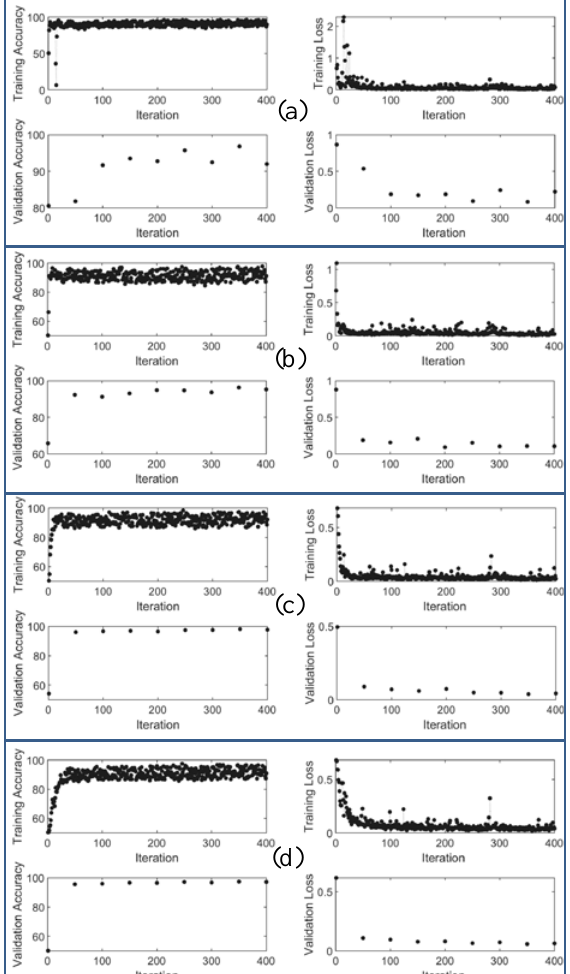
Figure 15. Training process of the DeepLab_v3+ using different learn rates. ( a ) 0.1, ( b ) 0.01, ( c ) 0.001, and ( d ) 0.0001. Table 6. Detection results of the DeepLab_v3+ using different learning rates.